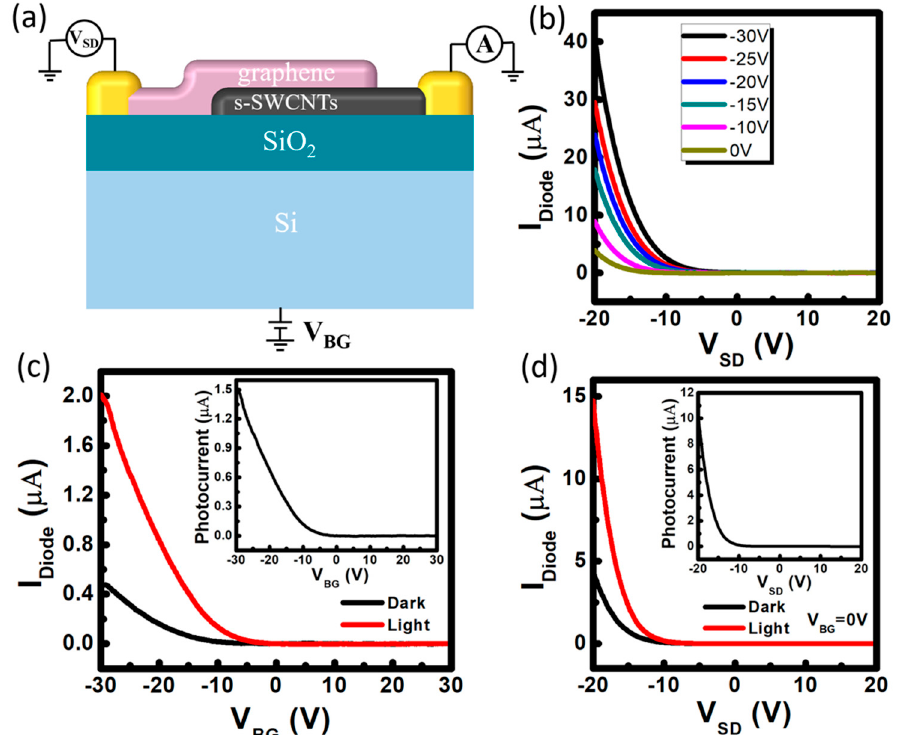
Figure 3. ( a ) Schematic of the graphene/s-SWCNT Schottky photodiode and the test perform circuit. ( b ) The output characteristics curve of the as-fabricated diode at different V BG . ( c ) The diode current as a function of back-gate bias for the Schottky device before and after under illumination (V SD = − 5 V). The insert is the corresponding I photo − V BG curves. ( d ) The V SD -dependent diode current with and